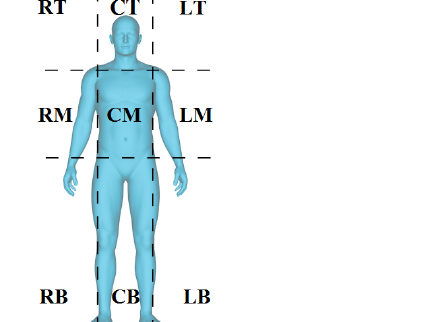
Right, Top , CT = Center, { } { , RM = Right, Middle , CM = } { } Left, Middle , RB = Right, Bot- { } { , LB = Left, Bottom . } { }